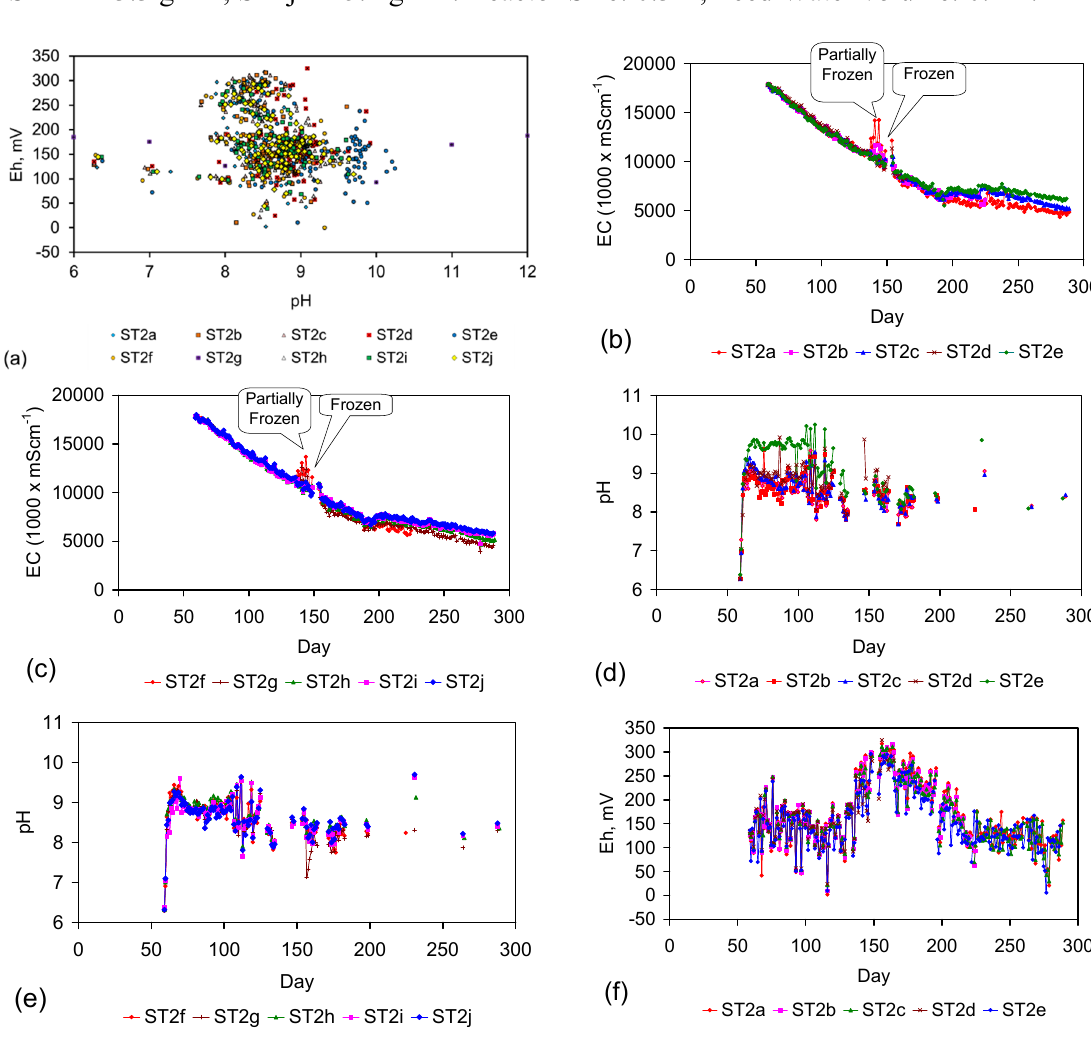
Figure C5. ( a ) pH vs. Eh; ( b ) EC vs. day, ST1a–ST1e; ( c) EC vs. day, ST1f–ST1j; ( d ) pH vs. day, ST1a–ST1e; ( e ) pH vs. day; ST1f–ST1j; ( f ) Eh vs. day, ST1a–ST1e; ( g ) Eh vs. day, ST1f–ST1j. ZVM TP = copper sheathed pellets (15 mm OD) placed in water at a concentration of ST1a = 18.3 g·L − 1 ; ST1b = 23.1 g·L − 1 ; ST1c = 25.3 g·L − 1 ; ST1d = 26.7 g·L − 1 ; ST1e = 21.7 g·L − 1 ; ST1f = 28.3 g·L − 1 ; ST1g = 31.9 g·L − 1 ; ST1h = 30.1 g·L − 1 ;